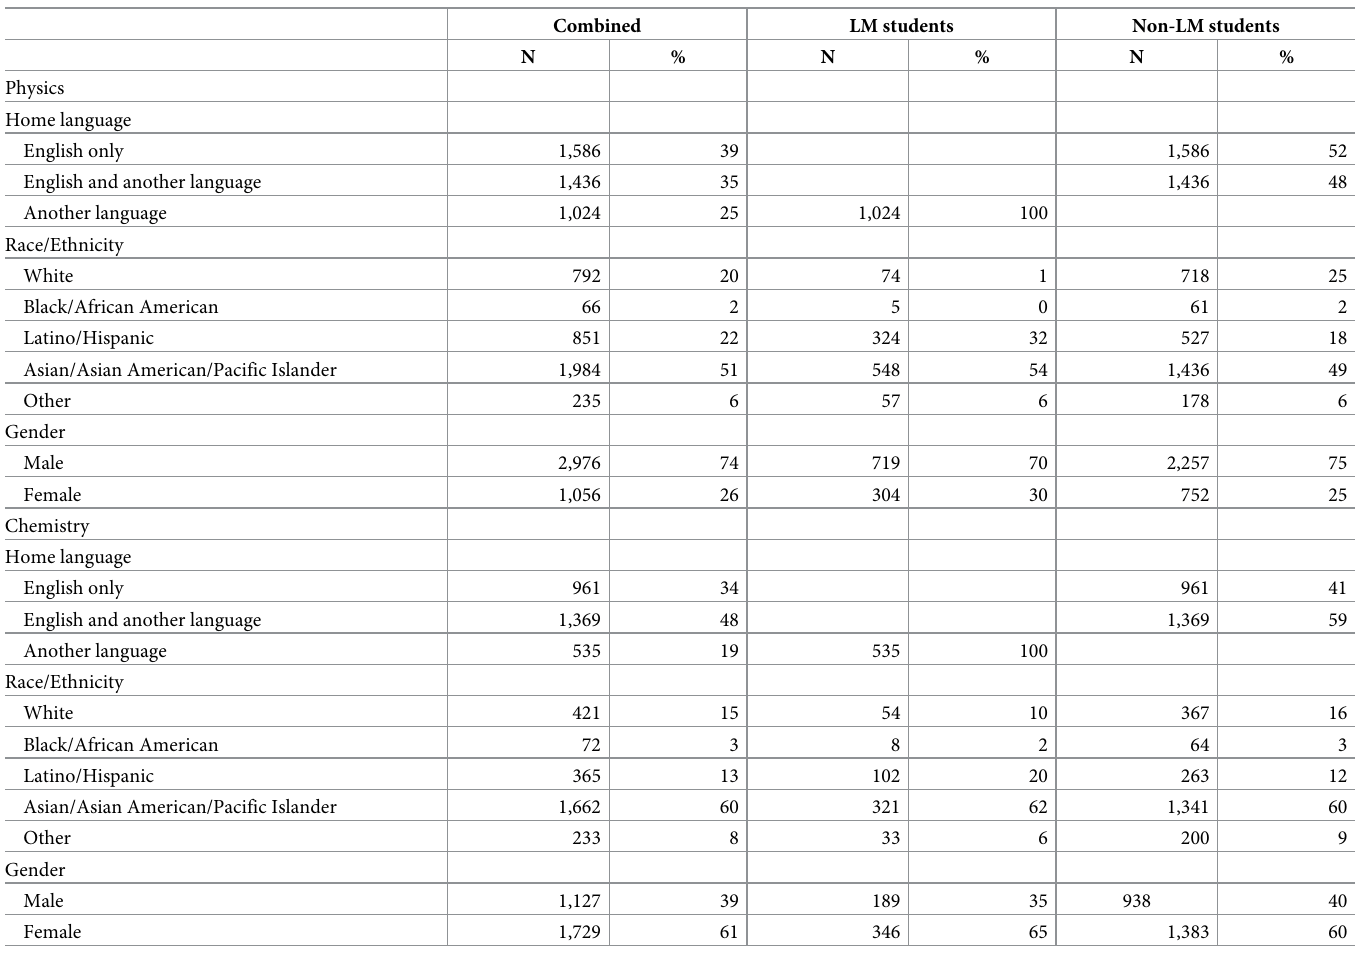
Table 1. Demographic information of study samples by language